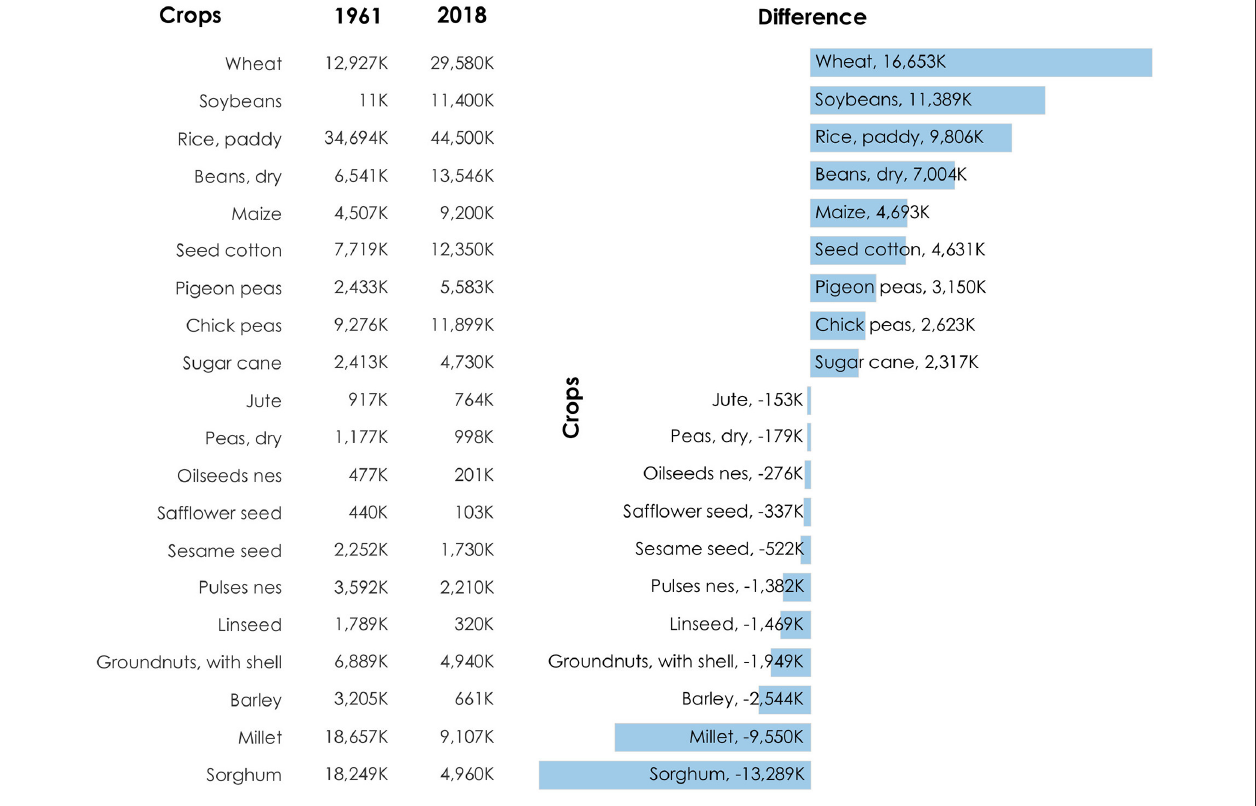
FIGURE 1 | Changes in area harvested of the crops from the years 1961 to 2018 (data source: FAOSTAT; FAO,